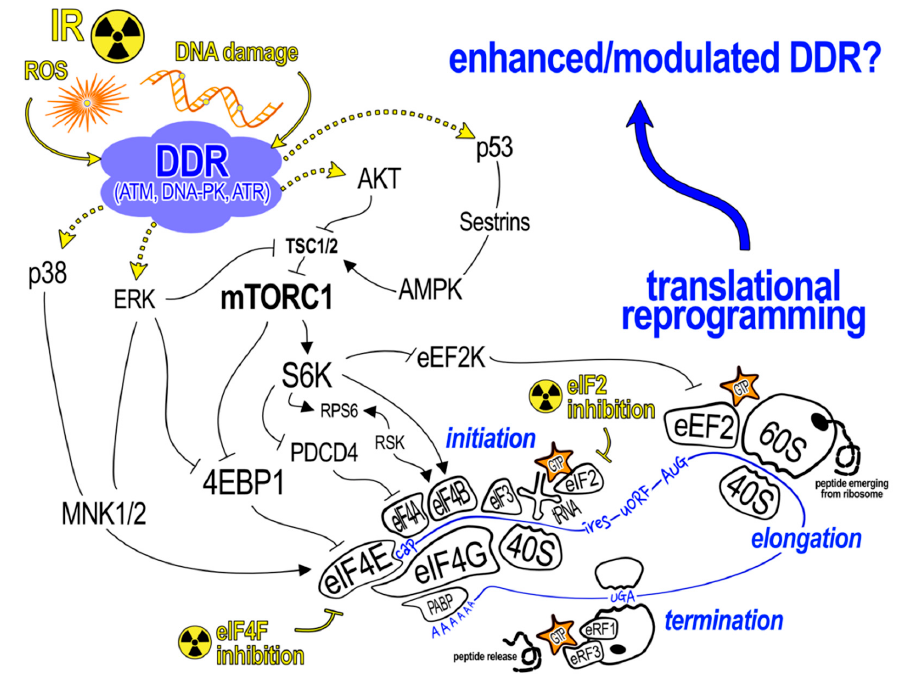
Figure 3. Cellular signaling pathways and molecules that might be involved in reprogramming mRNA translation following exposure to IR. Reactive oxygen species (ROS) and/or DNA damage produced as a result of high doses of IR are known to activate the DDR consisting of highly interconnected kinase cascades (ATM, DNA-PK, ATR). Stimulation of these pathways converges on known signaling cascades that regulate mRNA translation. The major steps of translation shown towards the bottom of the diagram in blue. Note that all 3 steps require energy in the form of GTP to nucleate the ribosome (made up of 40S and 60S ribosomal subunits) on the mRNA (initiation), to elongate the peptide chain (elongation) and to release the completed peptide (termination). Translation control is exerted largely at the initiation step and specifically by modulating the formation of the eIF4F cap-binding complex and/or activity of eIF2 through phosphorylation of its alpha subunit (eIF2 α ). Sequence motifs within mRNAs (shown in blue font along the mRNA and defined in the text) have different sensitivities to these control points, allowing the finely-tuned regulation of single species and/or groups of mRNAs. Radioresistant phenotypes (e.g., an enhanced DDR) could be mediated by translational reprogramming resulting from stimulation of these upstream pathways following LDR exposure.